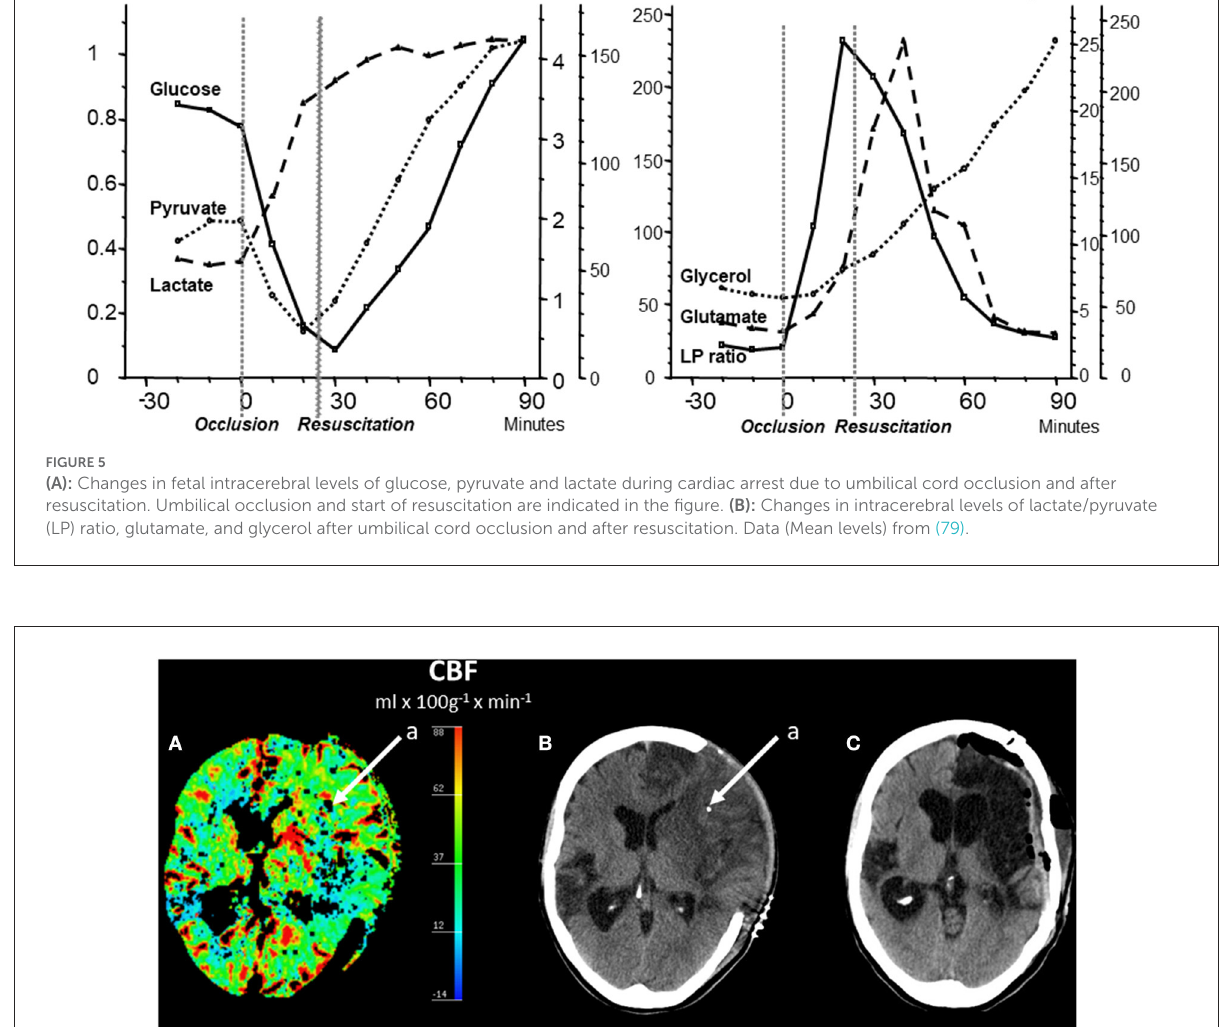
non-infarcted hemisphere (better) are shown for MCA blood flow velocity and glucose (Figure 7A), LP ratio and